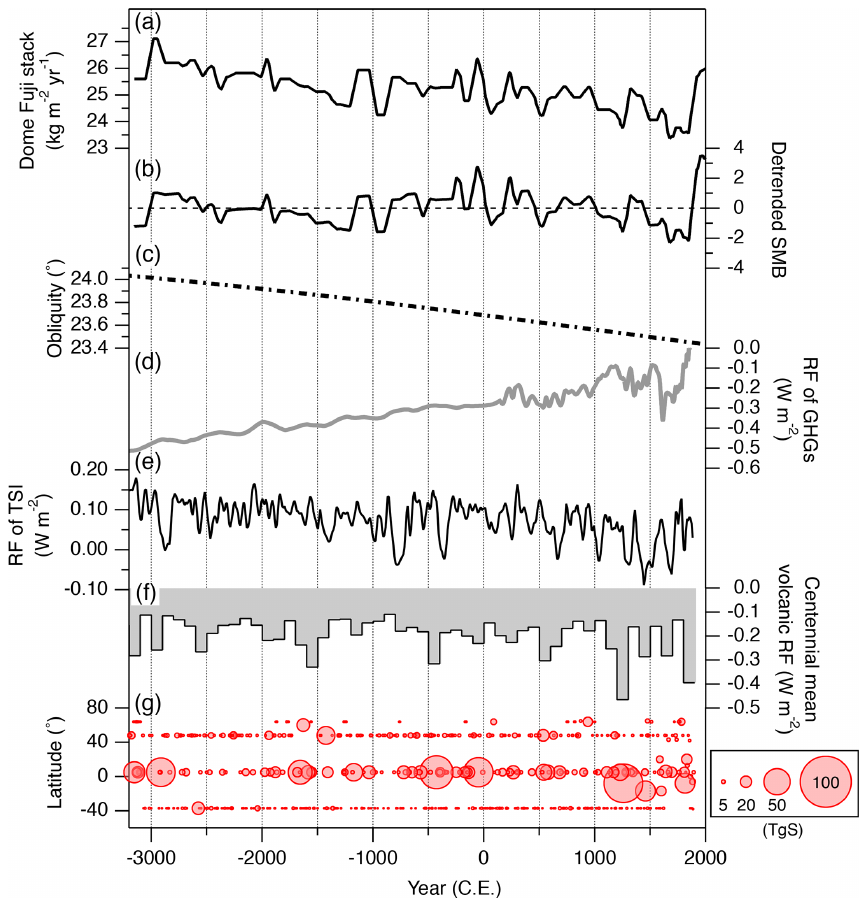
Figure 12. Dome Fuji SMB record and climatic forcings over the last 5000 years. (a) Dome Fuji stacked SMB (Stack 2); (b) detrended SMB of Stack 1; (c) obliquity; (d) radiative forcing (RF) of greenhouse gases (CO 2 , CH 4 and N 2 O) relative to 1750CE calculated using CO 2 , CH 4 , and N 2 O concentrations from Bereiter et al. (2015), Buizert et al. (2015), and Fischer et al. (2019), respectively, and equations proposed by Etminan et al. (2016); (e) RF of total solar irradiance (Wu et al., 2018) relative to 1750CE; (f) centennial mean volcanic RF at 40–90 ◦ S; and (g) stratospheric sulfur injections from volcanic eruptions (TgS stands for teragram of sulfur) (Sigl et al., 2022). Volcanic RF was calculated by stratospheric aerosol optical depth (Sigl et al., 2022) and a conversion factor (Hansen et al.,